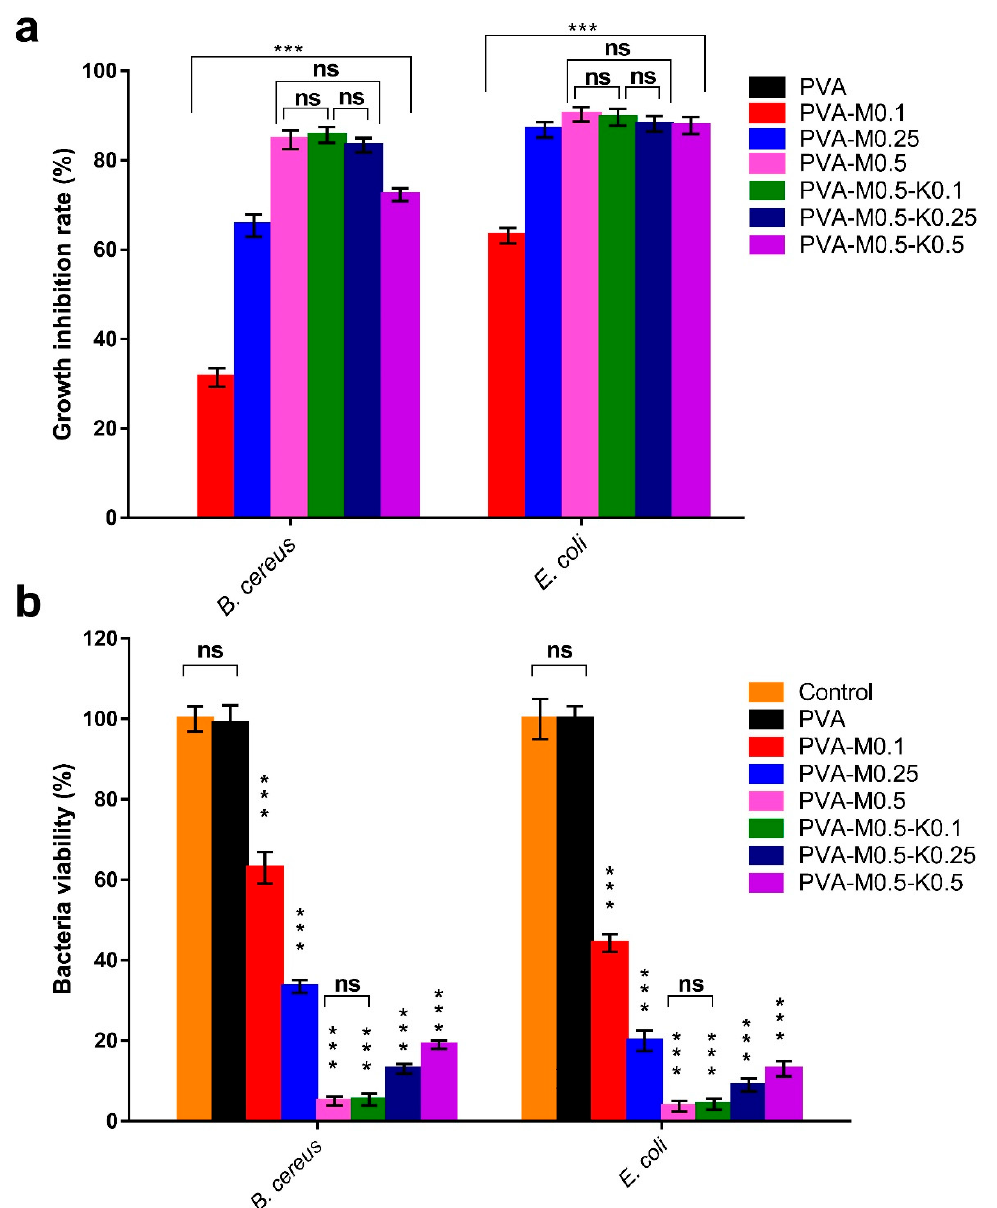
Figure 7. Antibacterial evaluations of PVA/marjoram and PVA/marjoram/kaolin composite sponges against B. cereus and E. coli compared to the pure PVA sponge adopting ( a ) growth turbidity method and ( b ) plate count method to determine the percentage of bacteria viability. Results are depicted as means ± SD ( n = 5) (*** p < 0.001, and (ns) points to non-significant difference).